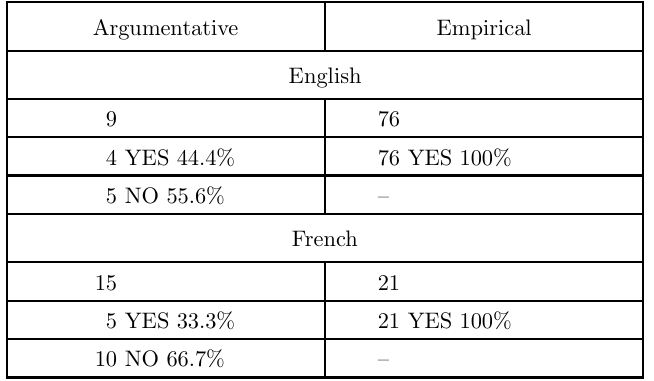
Number of abstracts respecting the full IMRD structure